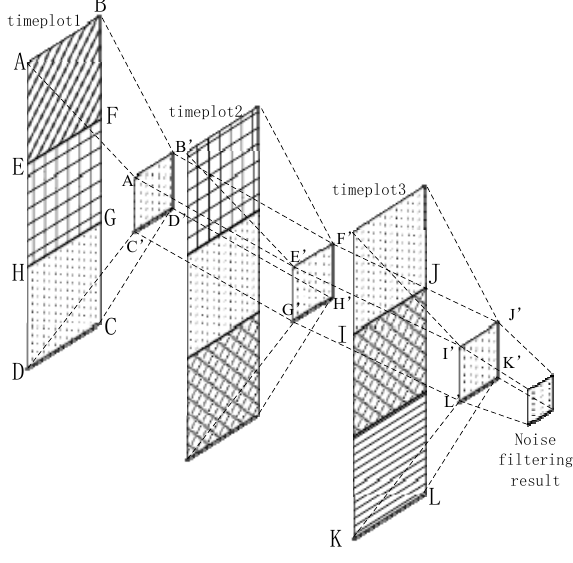
Figure 4. Noise filtering model.